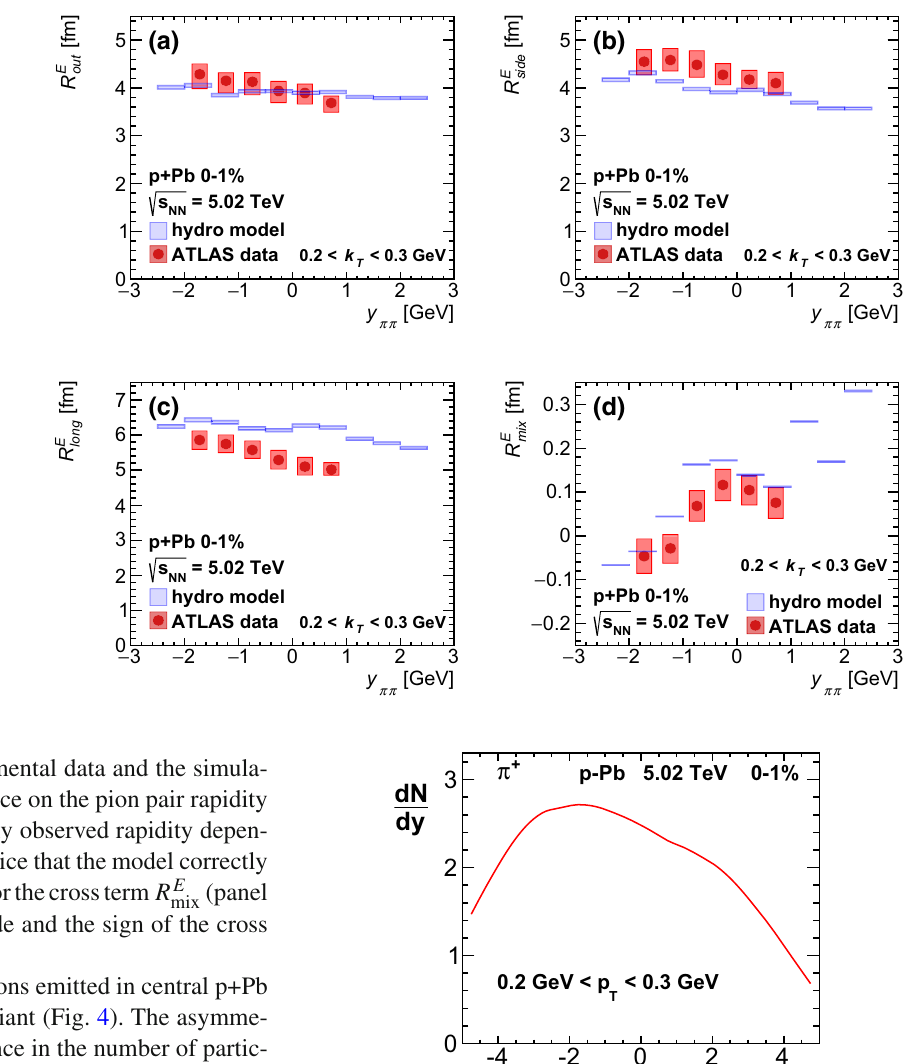
Fig. 4 Rapidity distribution of π + in central (0–1%) p+Pb collisions with 0 . 2 GeV < p T < 0 . 3 GeV, calculated in the viscous hydrody- namic model with Glauber Monte Carlo model initial conditions